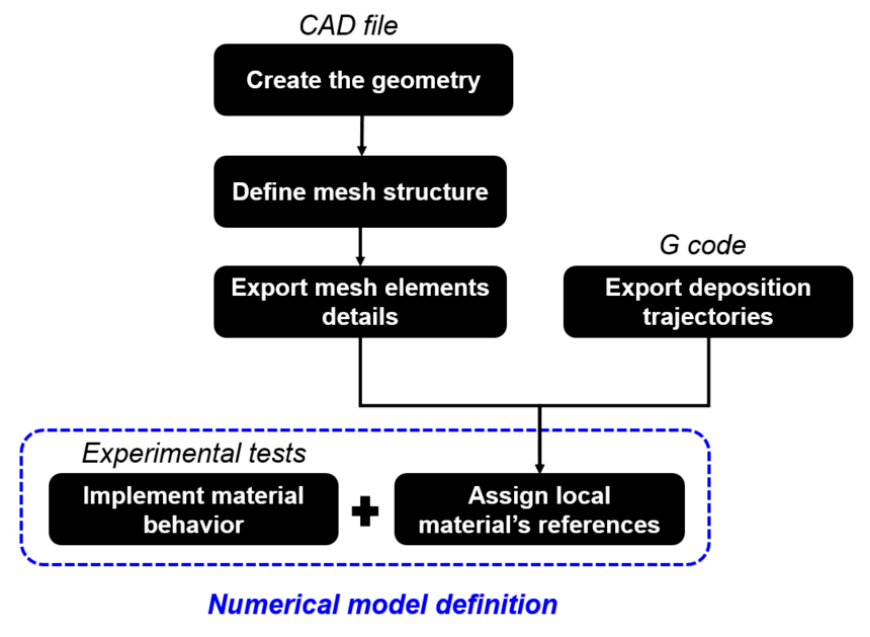
Figure 1. Workflow of the modeling methodology .